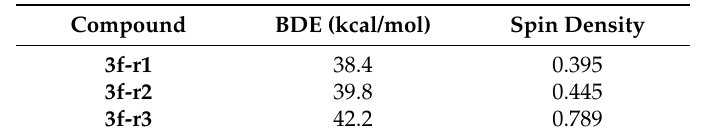
Table 2. Calculated properties for compound 3f .